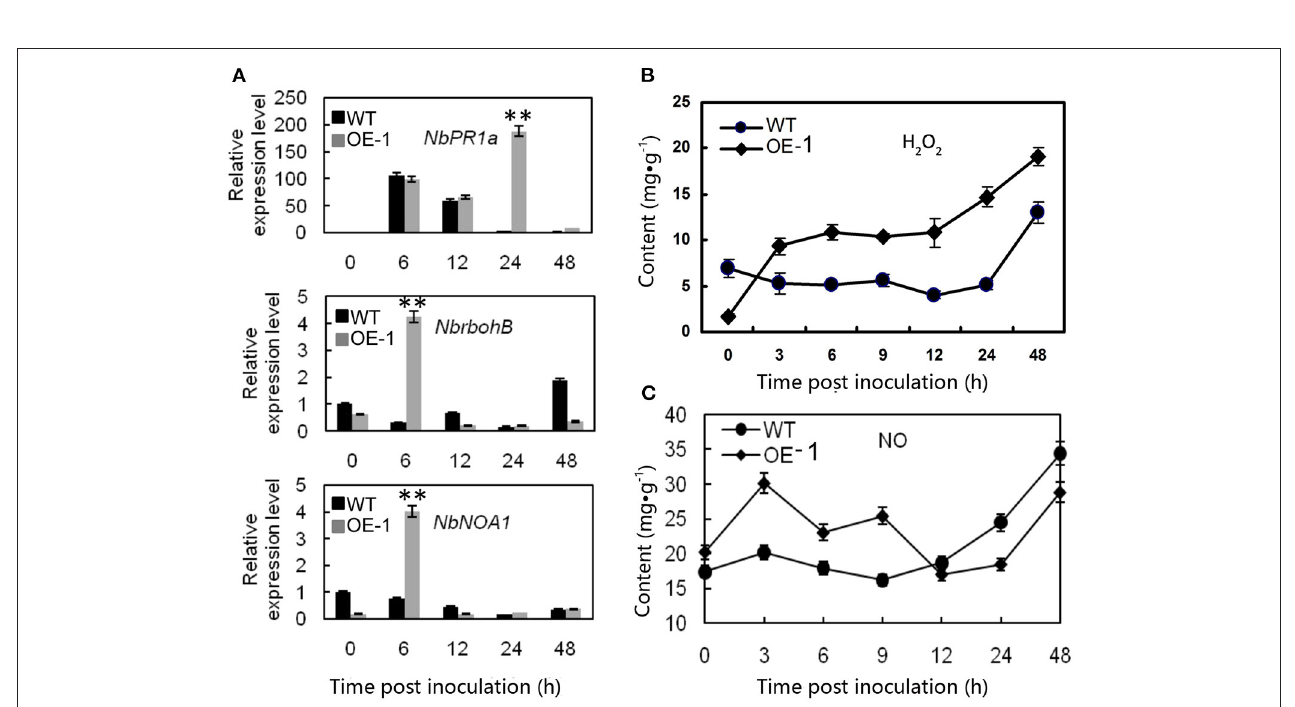
FIGURE 2 | Different effects of the gene expression and the H 2 O 2 and NO contents after R. solanacearum infection between wild-type (WT) and AtMYB12 overexpression tobacco (OE-1). (A) Relative expression analysis of NbPR1a , NbrbohB , and NbNOA1 after inoculation with the R. solanacearum SD1, which was performed 0, 6, 12, 24, and 48h post-inoculation. The values represent the average of three technical replicates. The values are the means ± SD ( n = 3, * p < 0.05, ** p < 0.01). (B) Detection of the concentrations of H 2 O 2 . (C) Detection of the concentrations of NO, which were determined 0, 3, 6, 9, 12, 24, and 48h post-inoculation. The values are the means ± SD ( n =